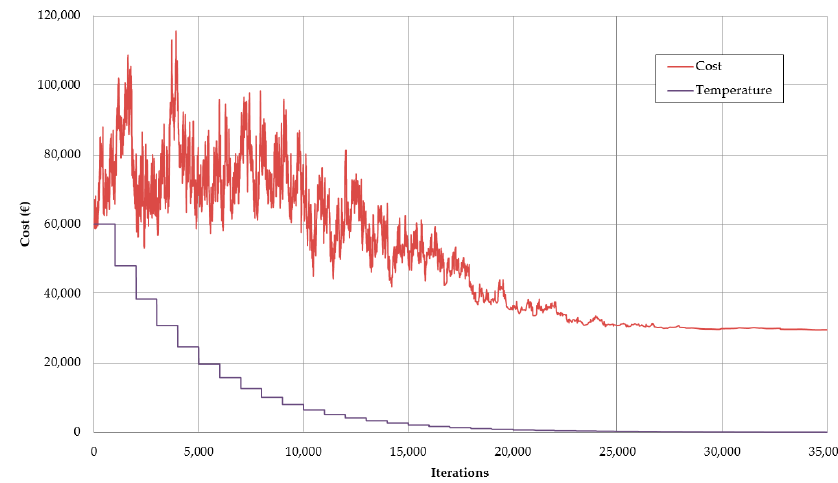
Figure 5. Trajectory cost and temperature-iterations.